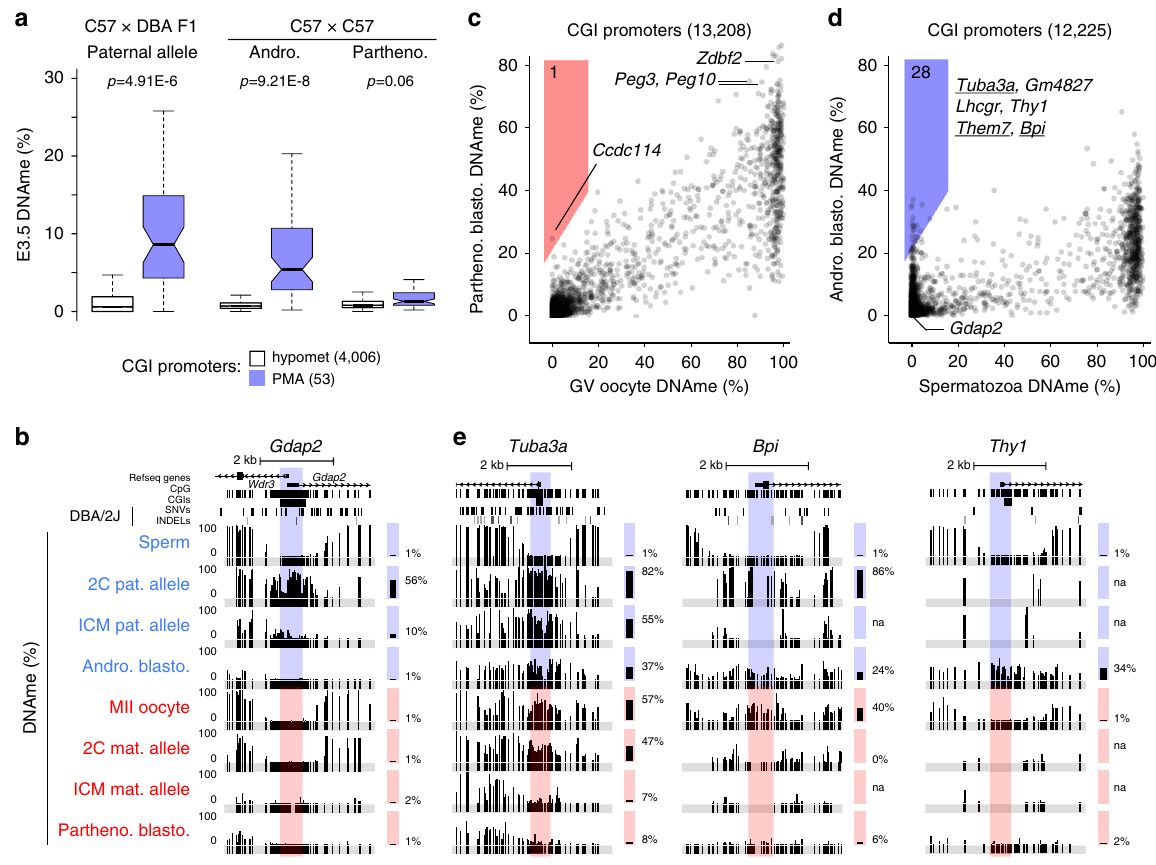
Fig. 2 Paternal DNAme levels at many PMA sites are maintained in normal and androgenetic blastocysts. a Distribution of hypomet ( n = 4006) and PMA ( n = 53) CGI promoter DNAme levels in embryonic day 3.5 C57 × DBA F1 ICM, androgenetic blastocysts and parthenogenetic blastocysts. Boxplots elements are as de fi ned in Fig. 1g. Outliers not shown. Two-sided t -tests assuming unequal variances were performed. b Screenshot of the Gdap2/Wdr3 CGI promoter, presented as in Fig. 1. c , d 2D scatterplots depicting DNAme levels over individual CGI promoters in E3.5 c parthenogenetic blastocysts versus GV oocyte (data excludes polar bodies; n = 13,208) and d androgenetic blastocysts versus sperm ( n = 12,225). Promoters that gain ≥ 20% DNAme are highlighted and genes previously identi fi ed using our allele-speci fi c DNAme analysis pipeline are underlined. e Screenshots of the Tuba3a , Bpi and Thy1 CGI promoters. Source data are provided as a Source Data fi